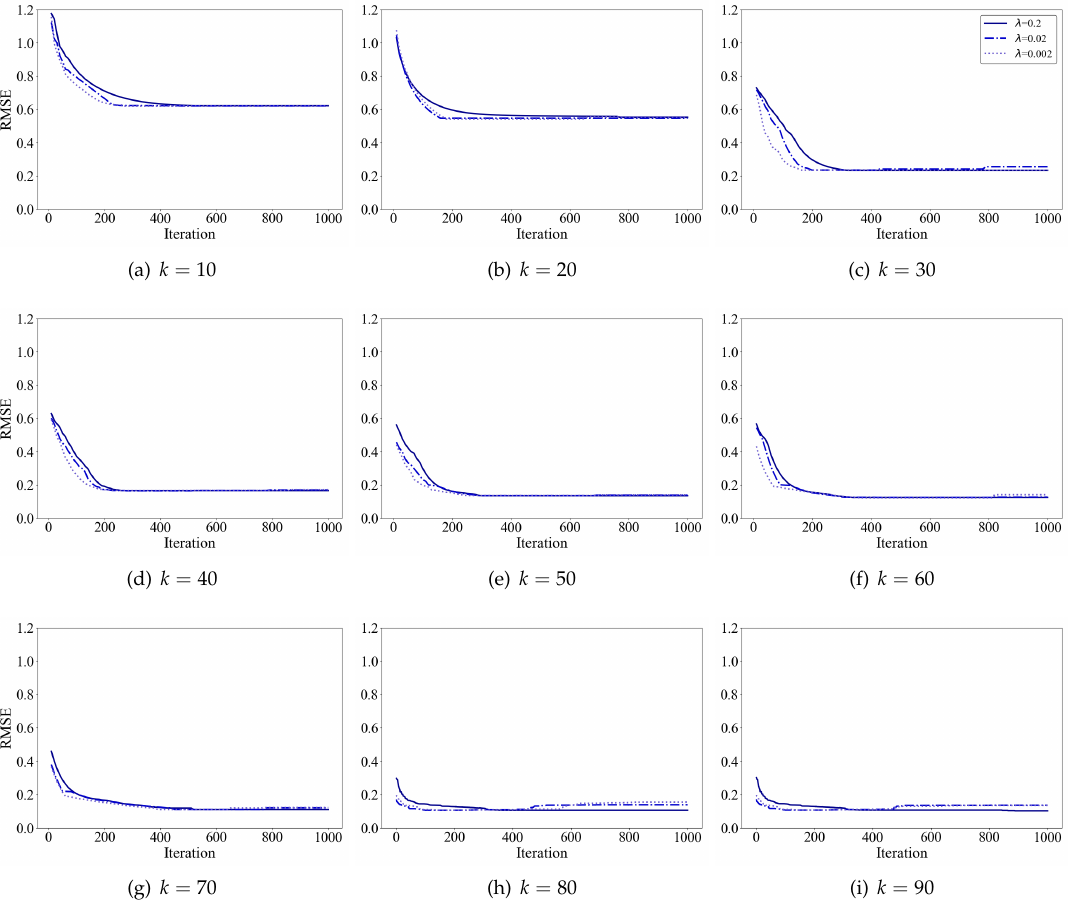
Figure 6. Recommendation performances of the proposed method with diverse λ s, 0.2, 0.02, and 0.002, and k s ranging from 10 to 90 at intervals of 10 in terms of RMSE according to the iteration